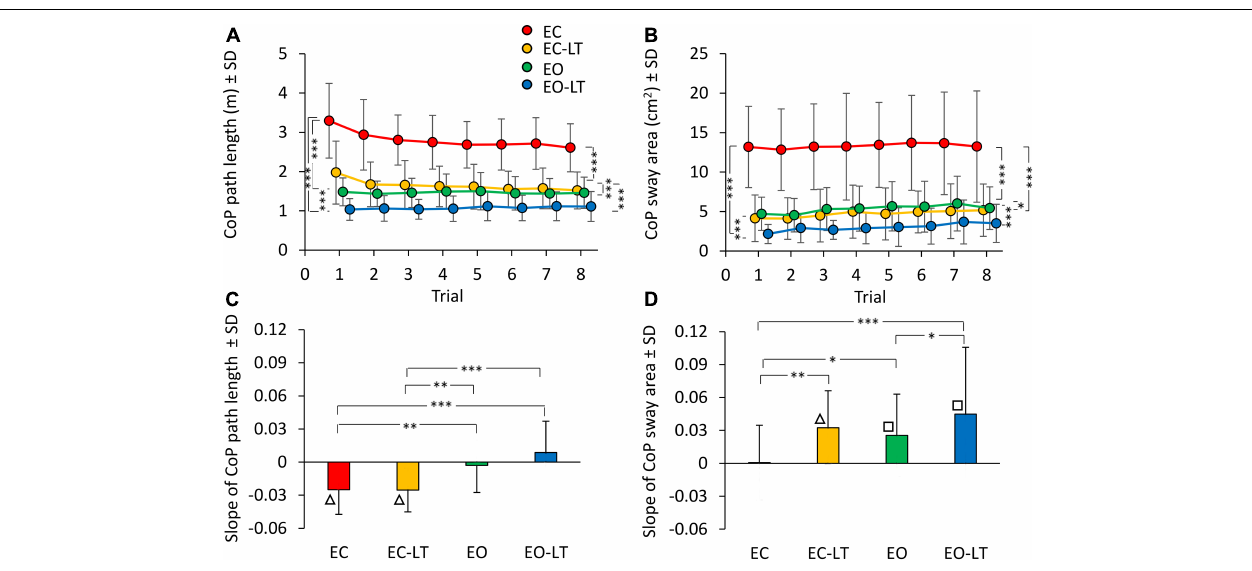
FIGURE 2 | Effect of trial repetition on path length and sway area of CoP excursions under different sensory conditions. Path length (A) diminished with trial repetition with EC (red) and EC with light-touch (EC-LT) (yellow), while no adaptation was evident with vision (eyes open (EO), green, and EO-LT, blue). Sway area (B) moderately increased with trial repetition for all conditions (less so for EC). (C,D) Show the mean slope of the lines fitted to path length and sway area values across the trials. The negative slopes with EC and EC-LT indicate a decrease in path length. Slopes were not different from zero with EO and EO-LT. The slopes for the sway area were positive, indicating an increase, except for EC. Asterisks indicate significant differences between sensory conditions (* p < 0.05; ** p < 0.01; *** p < 0.001). Symbols indicate slopes different from zero ( (cid:3) p < 0.01; (cid:77) p < 0.001).